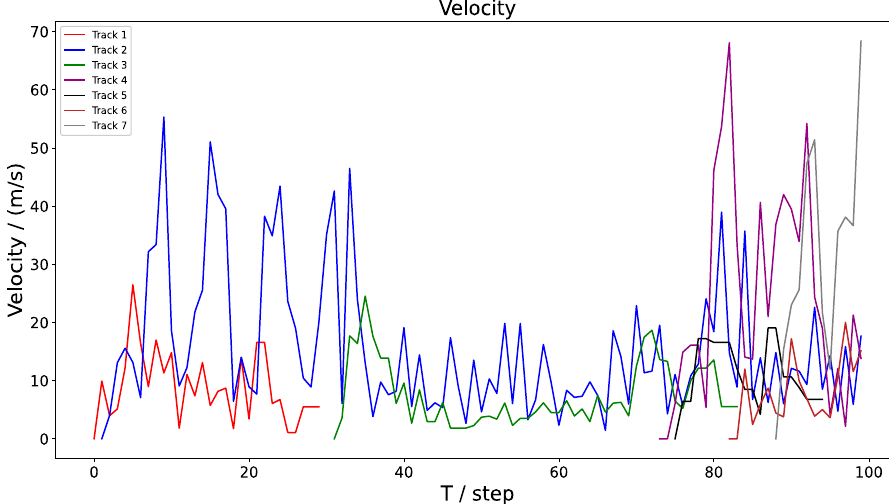
Figure 30. Multi-target velocity estimation (CMKF-REMTT).